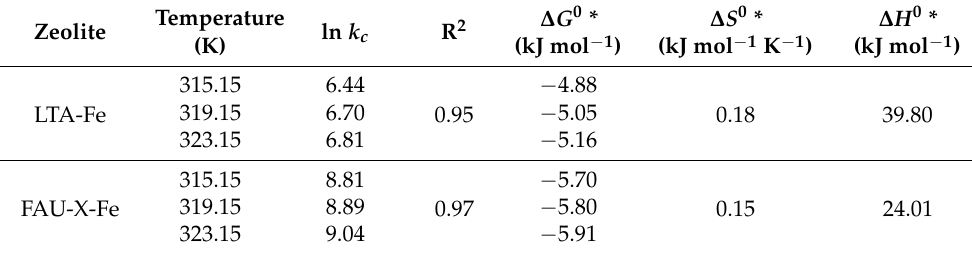
Table 5. Phosphate thermodynamic parameters for LTA-Fe and FAU-X-Fe. Zeolite